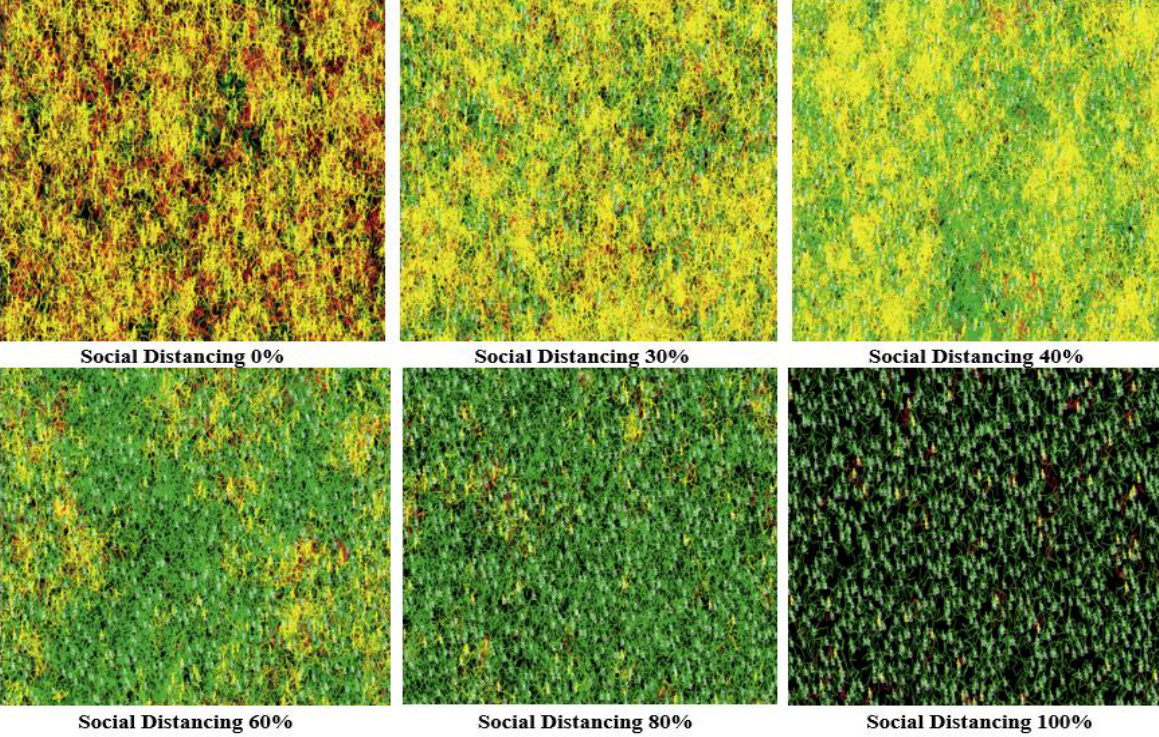
Figure 15. The final visual outputs of applying different levels of social distancing (without tracing individuals’ movement).